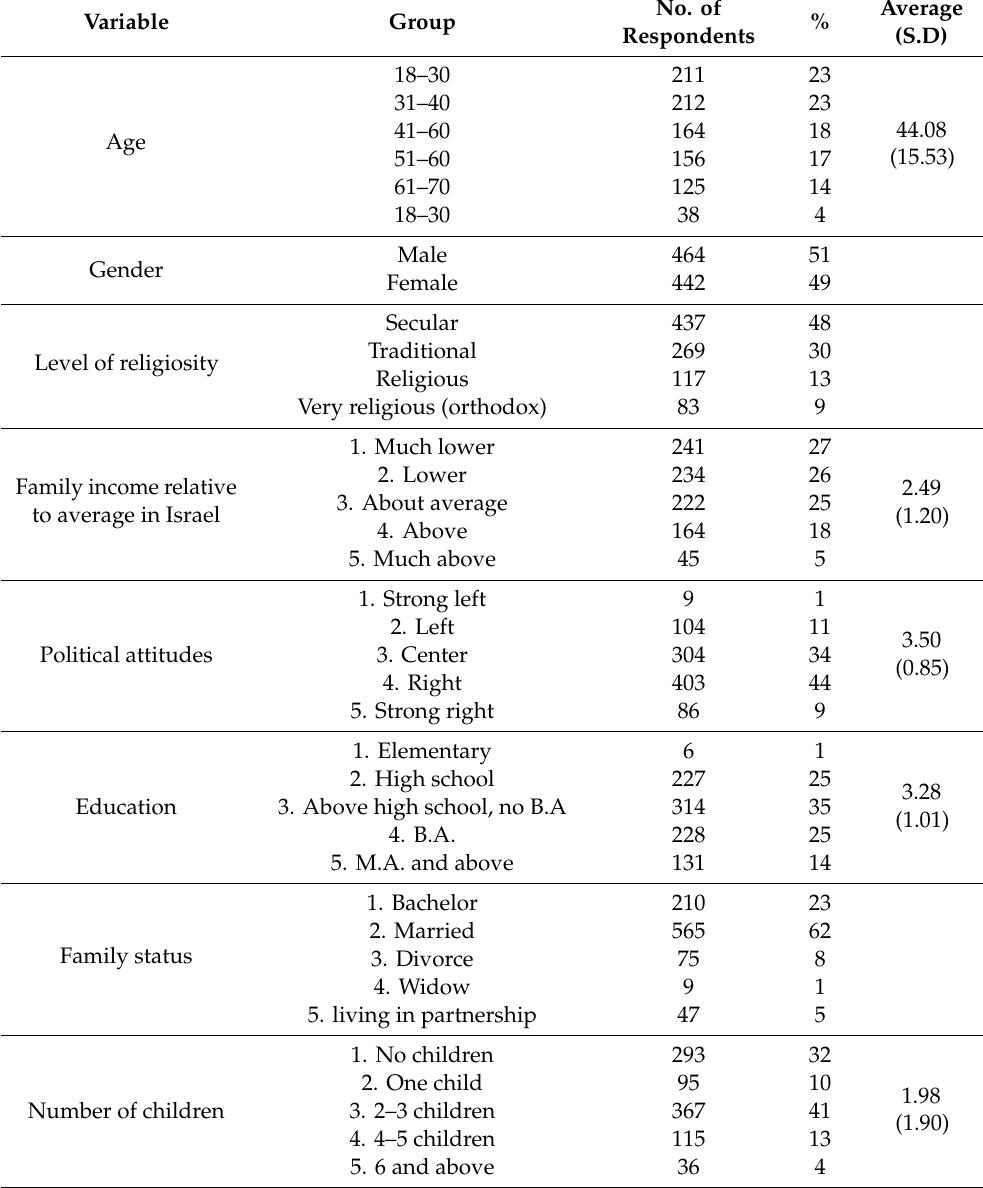
Table 1. Demographic characteristics of the respondents ( n =